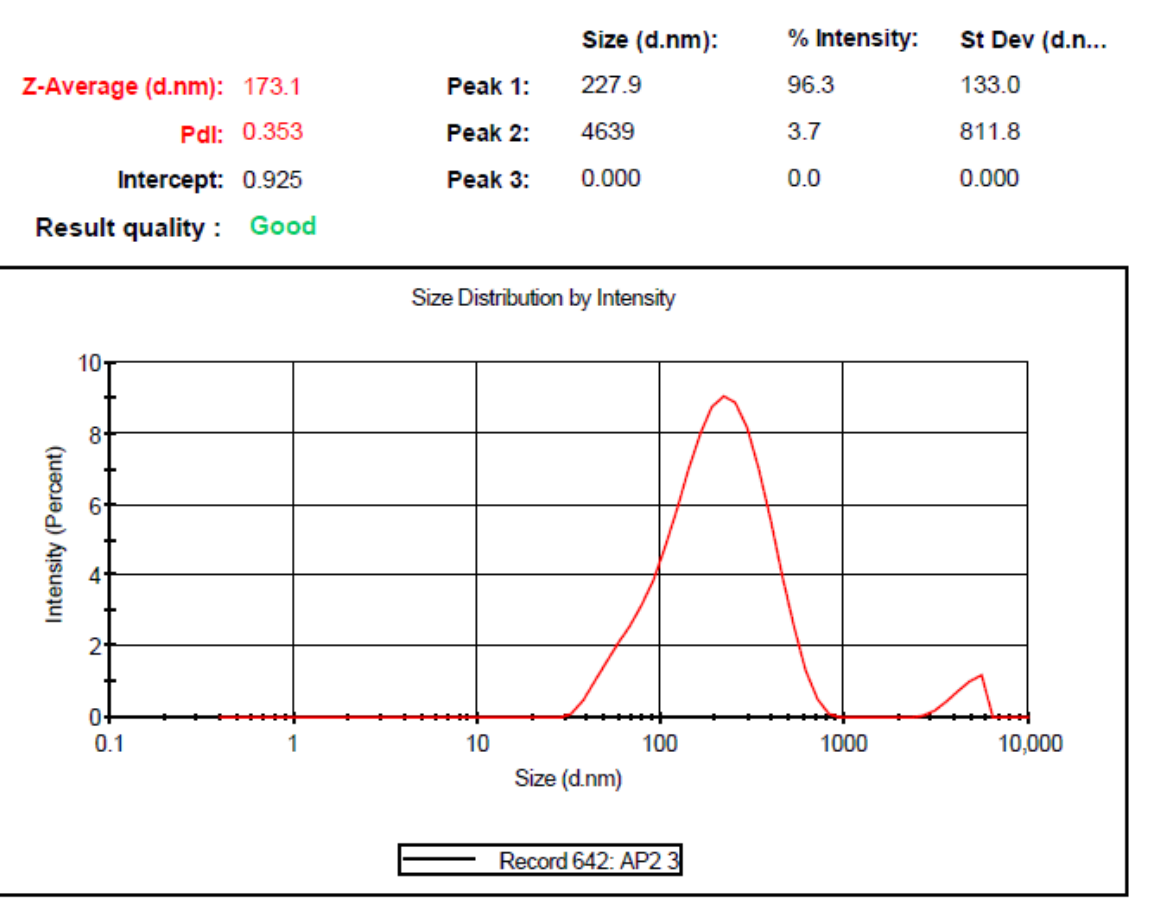
Figure 3. Globule size and PDI of optimized QCT@NE.